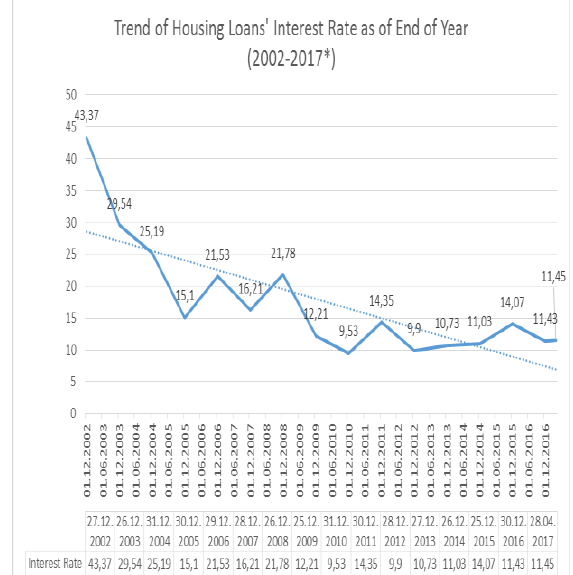
Figure 9. The Share of Housing Loans in Individual Loans (2005-2017*)